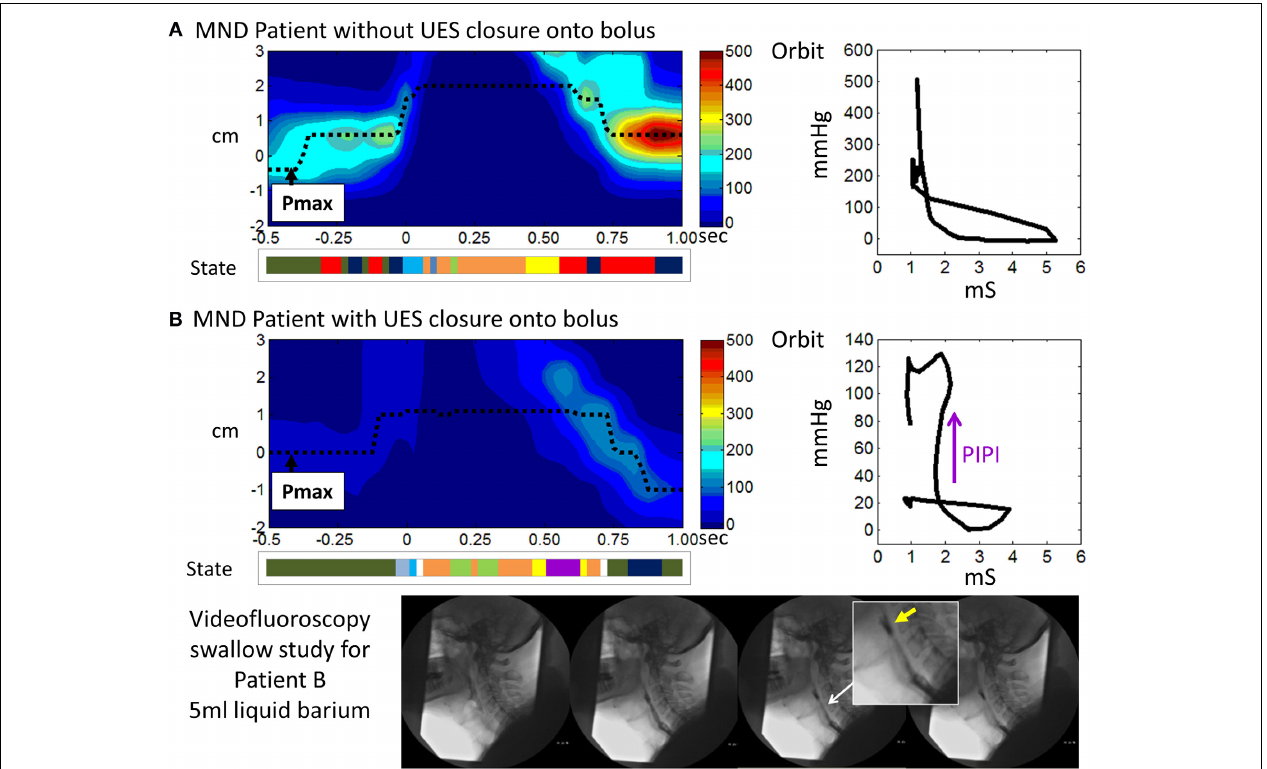
FIGURE 14 | Illustrative examples from MND patients. (A) An early stage MND patient (Female 69 years) who still swallows well. (B) A patient with more advanced MND (Male 62 years) in whom the mechanical state of Passive-Isometric Pressure Increase (PIPI) is predicted by the model to occur with luminal closure. Spatio-temporal pressure plots show the pressures of UES high pressure zone during a 5ml liquid swallow. Pmax defines the position of maximum axial pressure. A representation of the UES mechanical states predicted for the swallows is shown below each plot (color scheme identical to previous Figures, PIPI